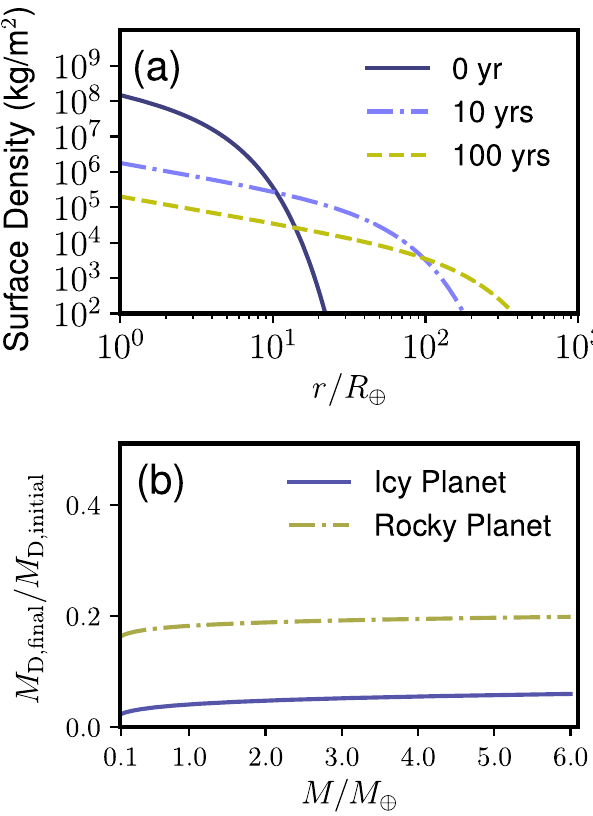
Fig. 7 Evolution of completely vapor disks. a Evolution of the surface density of the Moon-forming disk as a function of r/ R ⊕ . The purple solid line, light purple dashed-dotted line, and the yellow dashed line represent the surface density at 0 year, 10 years, and 100 years, respectively. b The fi nal disk mass normalized by the initial disk mass for icy planets (solid purple line) and rocky planets (dashed yellow line) as a function of the planetary mass M normalized by M ⊕ . For the details, see the main